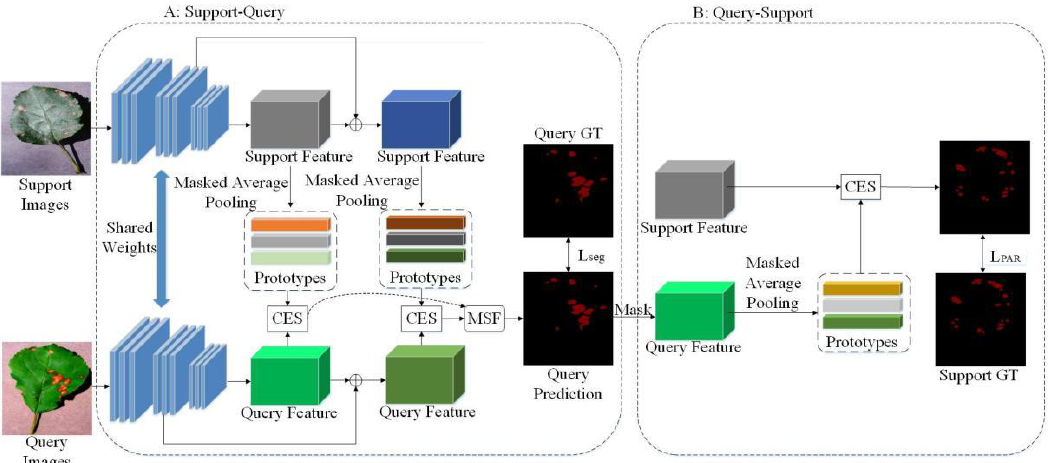
Figure 1. The overall pipeline of our proposed network(A: The model derives the diseased area of the query image from the support image with the diseased label; B: The model reversely deduces the diseased region of the support image by deriving the diseased region of the query image).